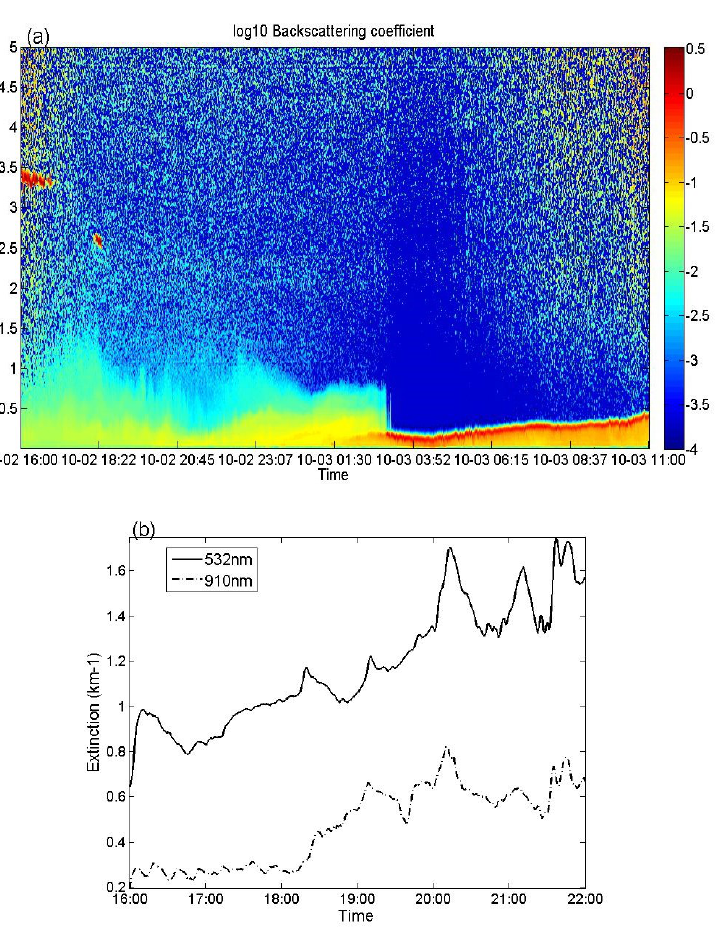
Figure 2. Sequence diagram of backscattering ( a ) and diurnal change of extinction coefficients ( b ).